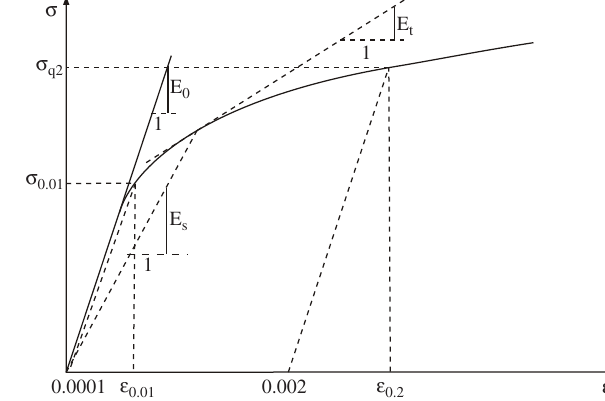
Figure 1. Typical non-linear stress-strain curve.